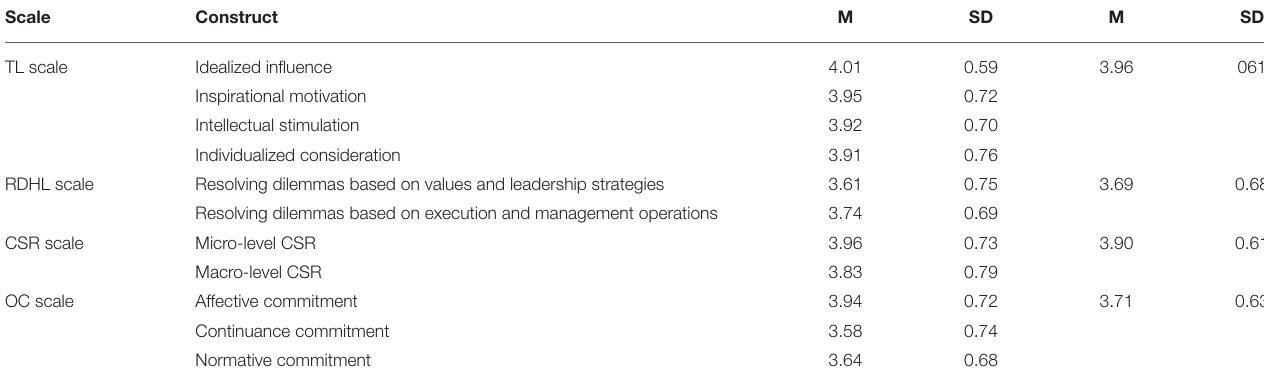
TABLE 2 | Summary table of descriptive analyses of each question and construct.